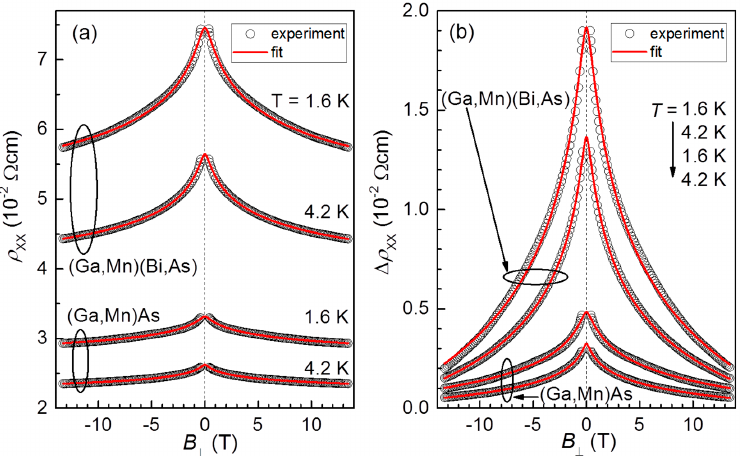
Table 1. The best fit values of fitting parameters: ρ c , F σ , and L so , corresponding to the fitted curves in Figure 7.